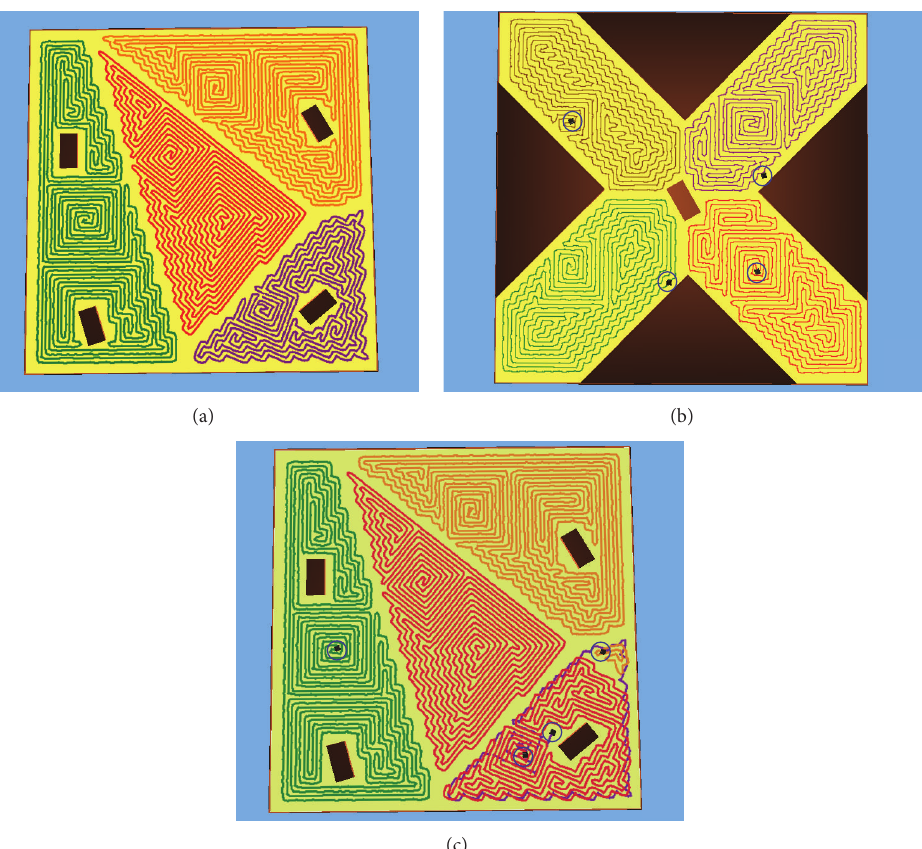
Figure 6: 4 robots marked by blue circles cover (a) a 20 m × 20 m square environment and (b) an X-shaped region within this environment using VPC algorithm. (c) One robot fails in the same setting as in scenario (a), and an operational robot takes over coverage of the failed robot’s Voronoi region.